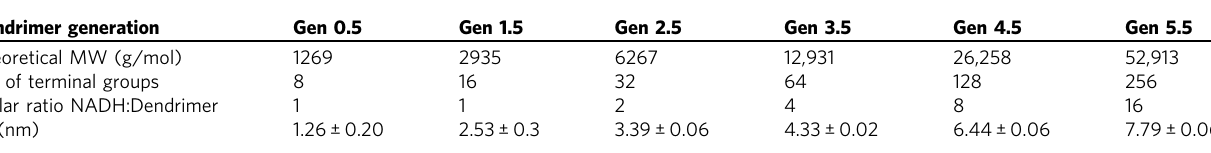
Table 1 Details on stock dendrimers and values used to calculate molar ratios for synthesis and measured R H values of NADH- Neg